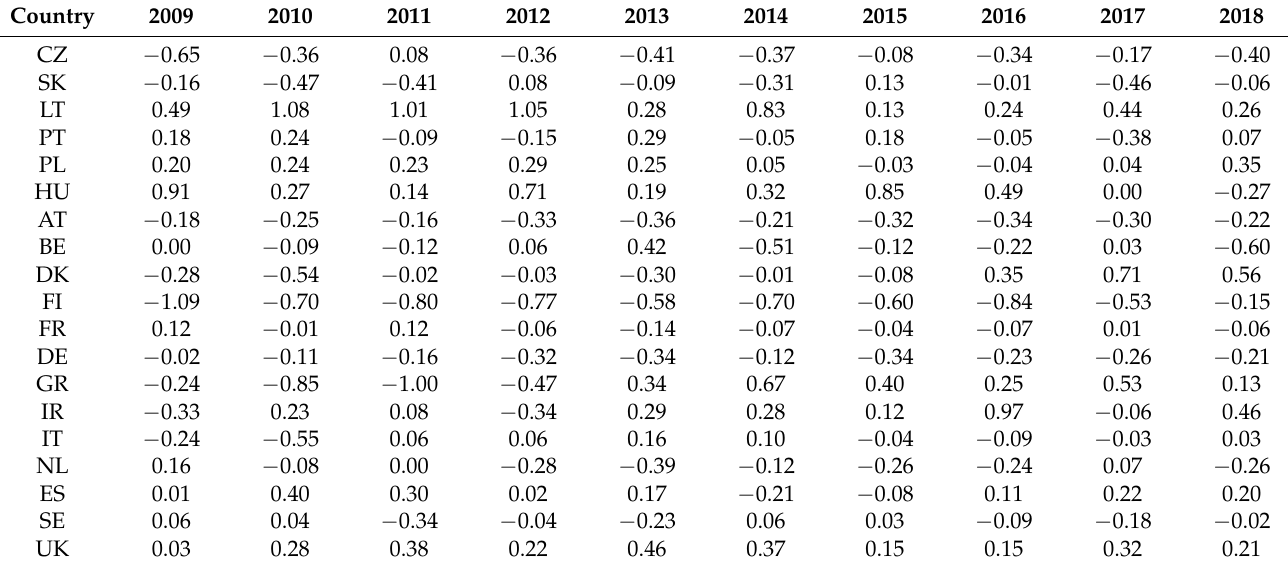
Table 5. EU paper pulp and printing industry (ISIC 17–18) competitiveness measure index, 2009–2018. Source: own processing.